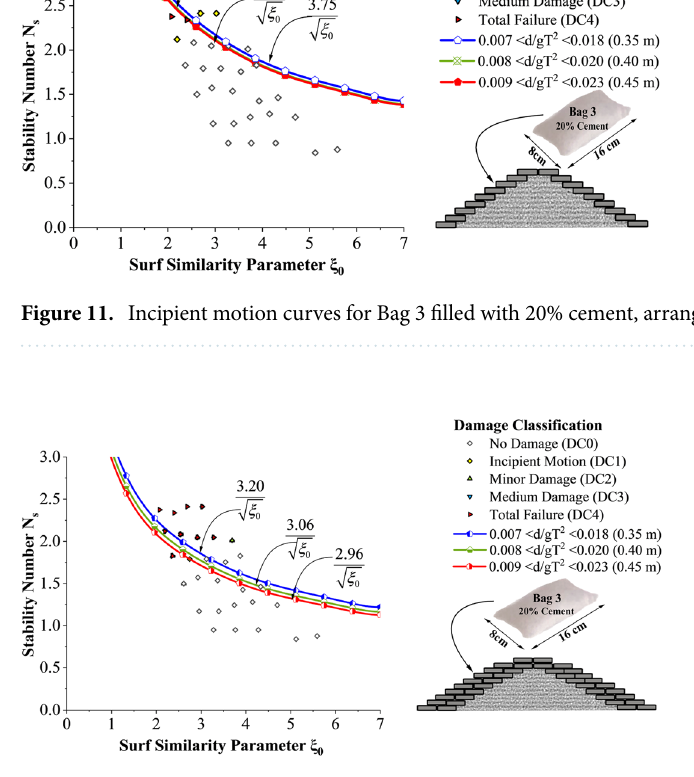
Figure 12. Incipient motion curves for Bag 3 filled with 20% cement, double layer.